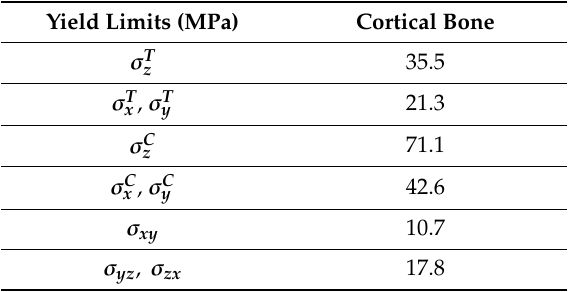
Table 2. Yield limits of cortical bone (tensile, compression and shear limits).